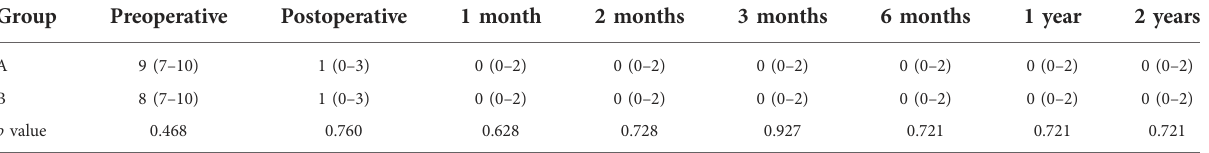
TABLE 3 VAS pain assessments of legs between two groups.